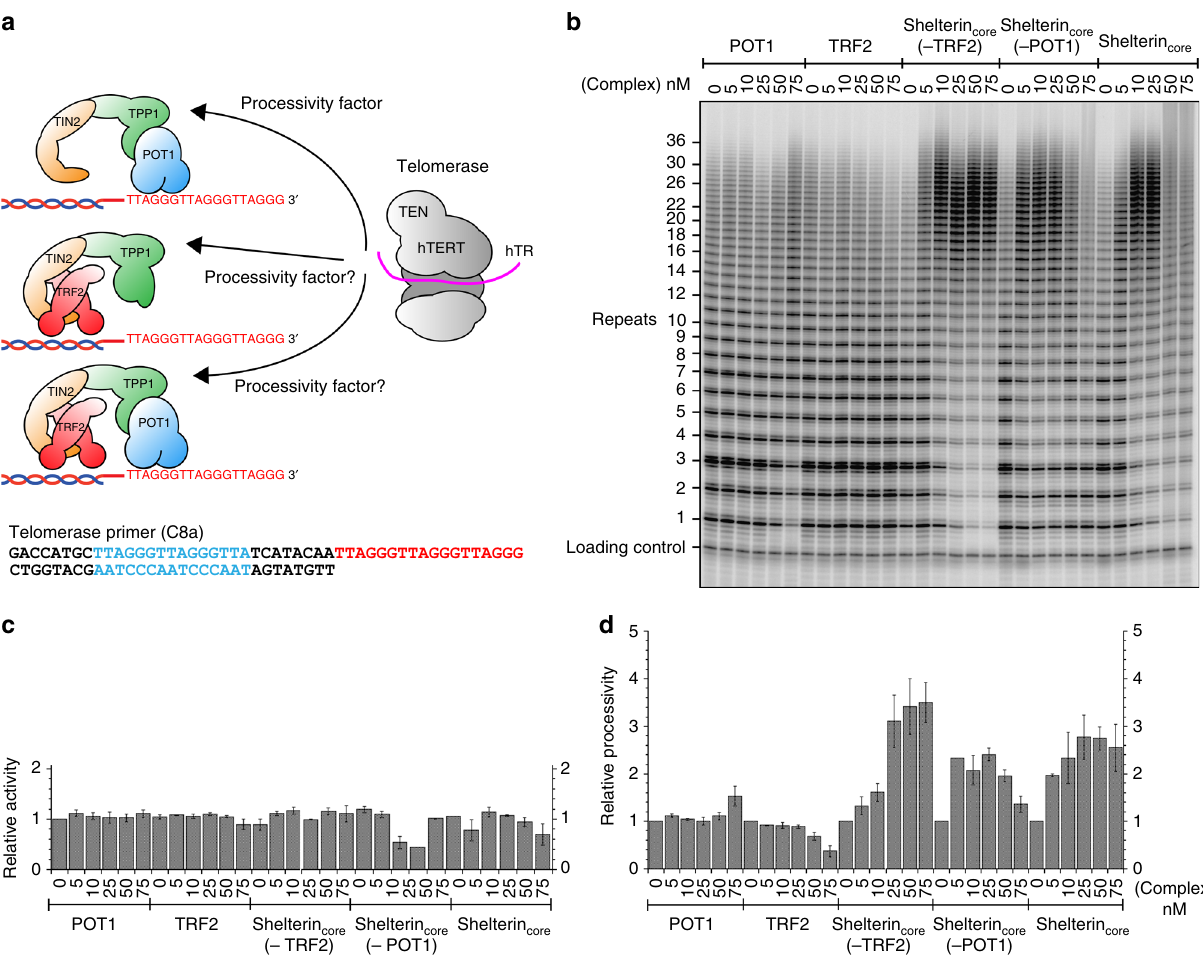
Fig. 6 TPP1 tethering is suf fi cient for shelterin enhancement of telomerase processivity. a Cartoon schematics of the shelterin complexes tested and the primer used (C8a), which allows binding of TRF2, POT1 and telomerase. b Direct telomerase assay to determine the effects of shelterin complexes on telomerase activity and processivity. c Total activity of telomerase primer elongation products (normalized to a radioactive oligonucleotide loading control) with bound shelterin protein complexes at various concentrations (nM). d Telomerase processivity with each shelterin protein/complex. The processivity (relative to no-protein lane, which is normalized to 1) was calculated by dividing the counts > 14 repeats by total counts. (Error bars in panels c and d indicate the range for two independent